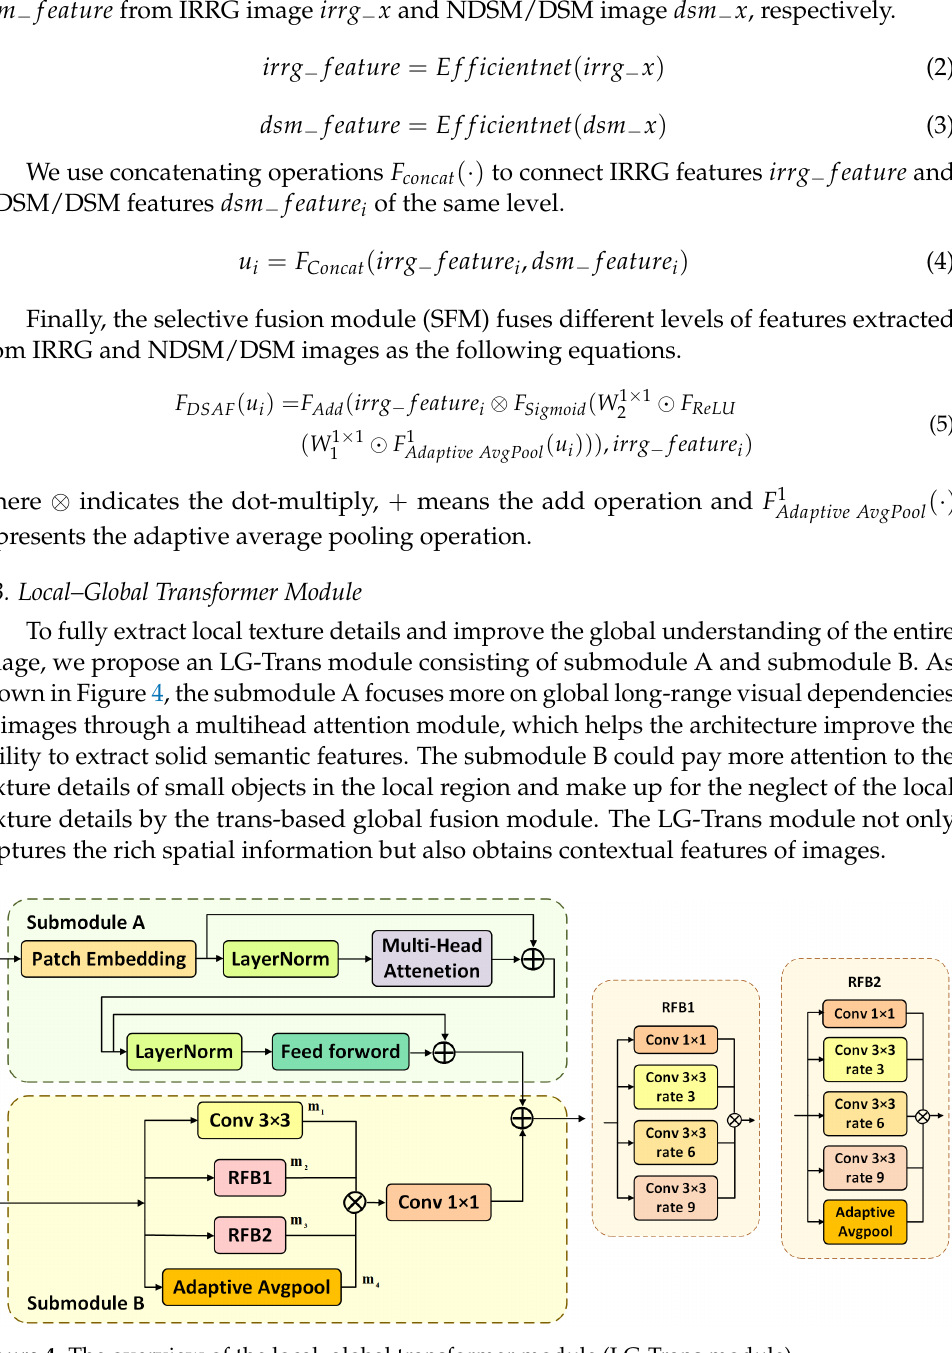
Figure 4. The overview of the local–global transformer module (LG-Trans